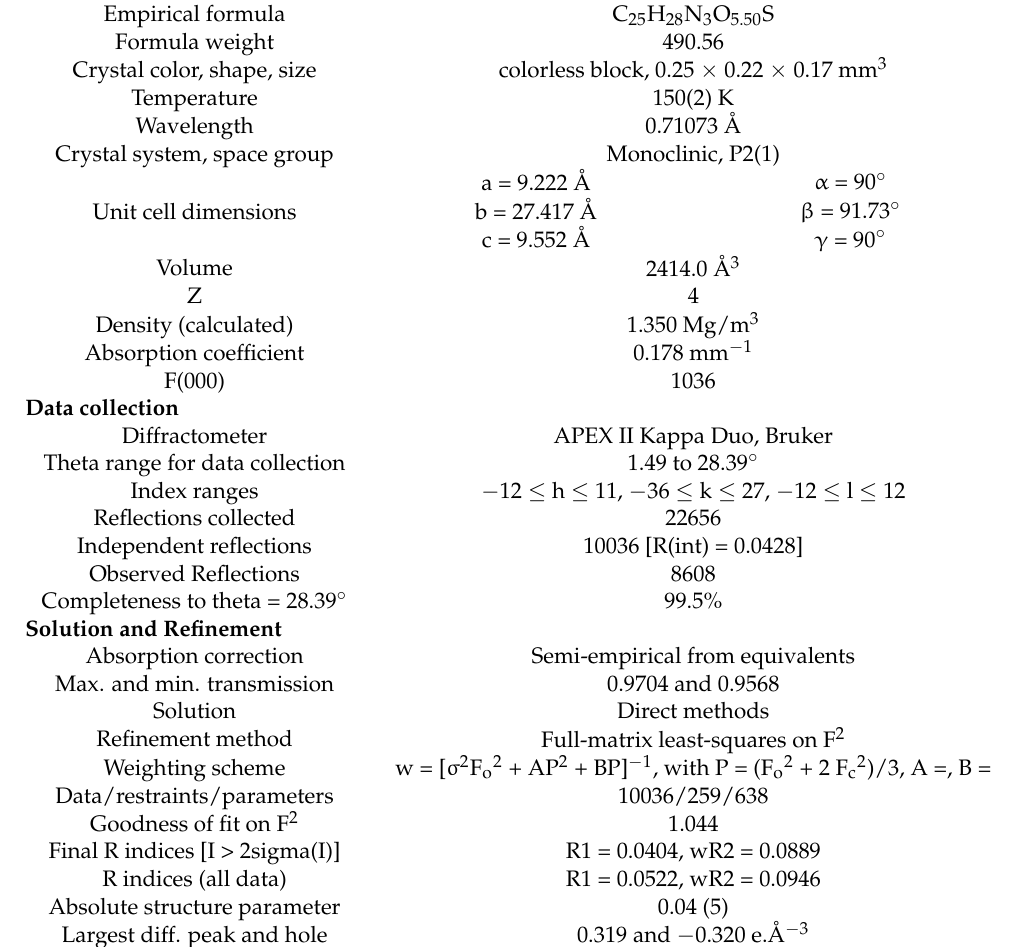
Table 1. Crystal data and structure refinement for β - 26c (Reciprocal Net report